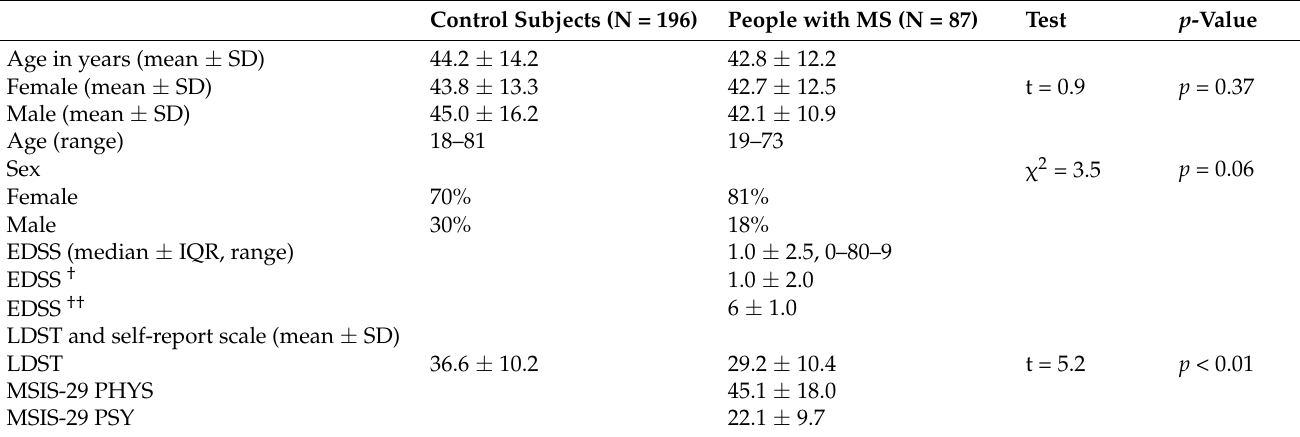
Table 1. Characteristics of study